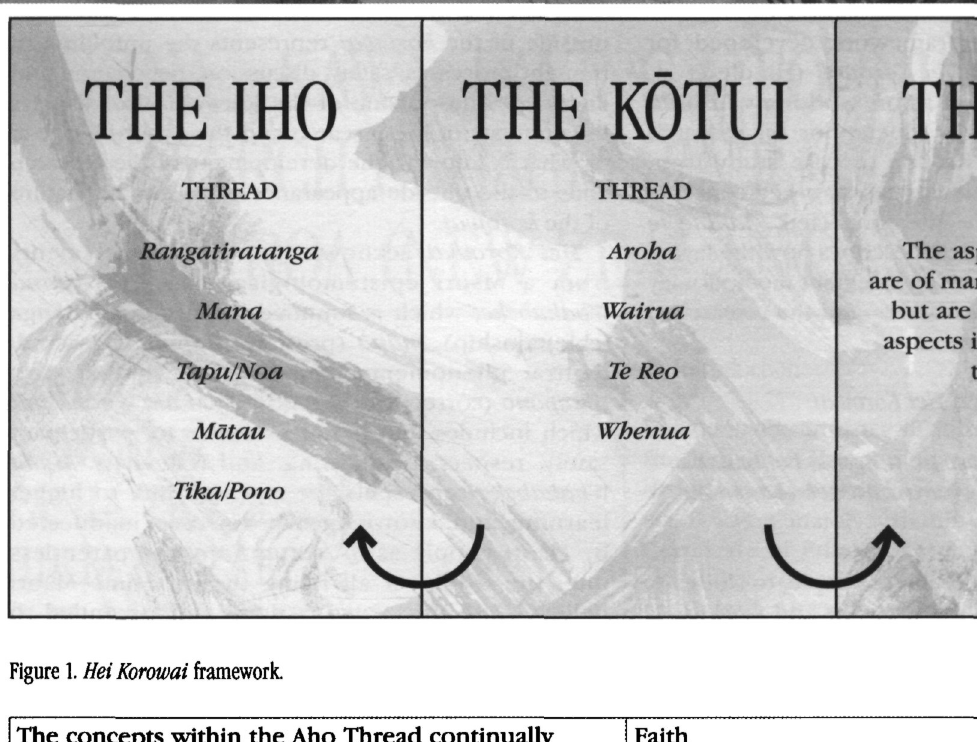
Figure 1. HeiKorowai framework.